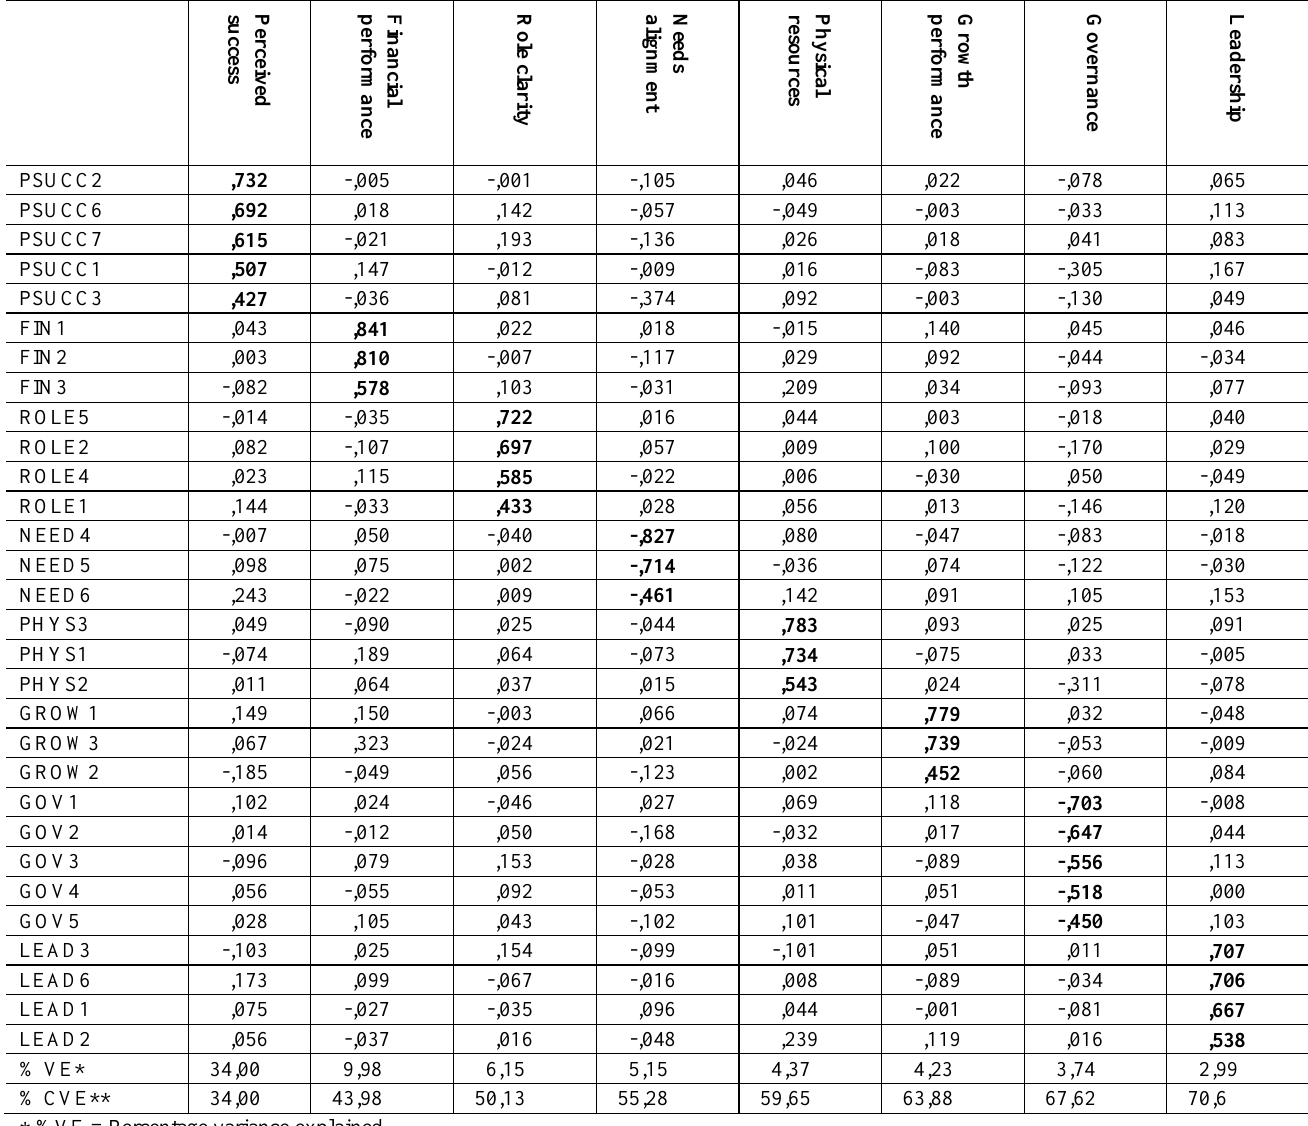
Table 1: Rotated factor matrix